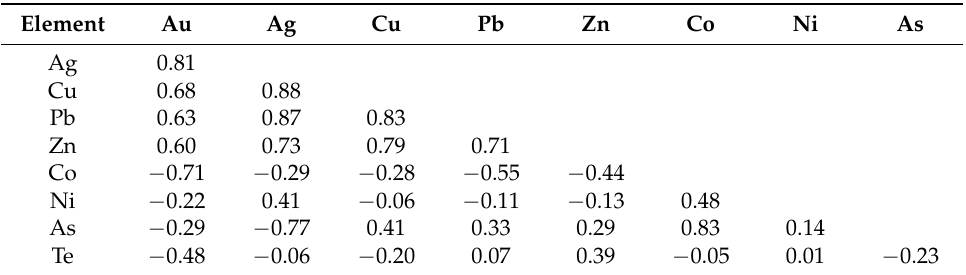
Table 3. Correlation coefficients between trace elements in Py2 from the Huanxiangwa gold